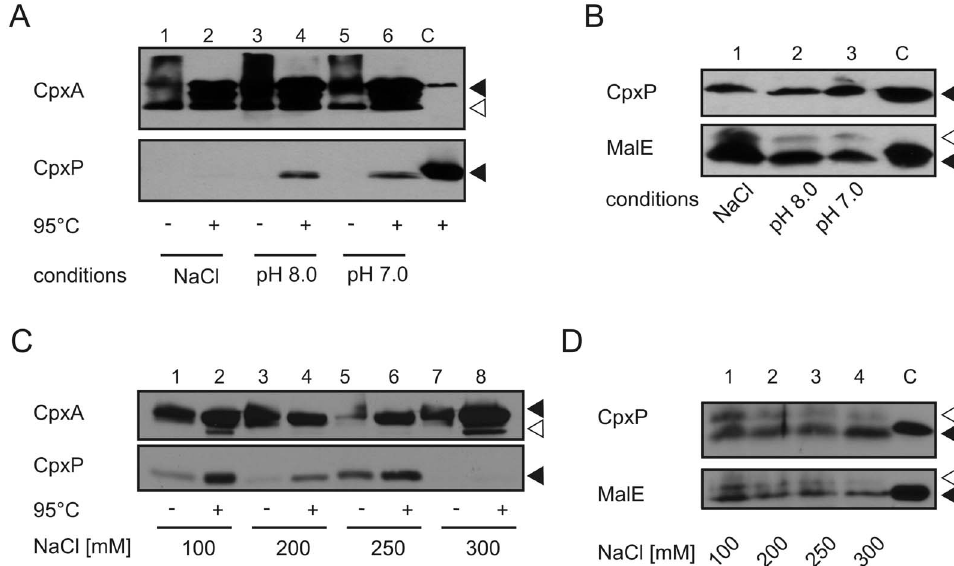
Figure 4. Salt but not alkaline pH disturbs the direct interaction between CpxP and CpxA. A) mSPINE experiments were performed as described in Fig. 2A with E. coli TG1 producing CpxA-Strep (pKT01E) and CpxP (pBcpxP) grown in standard LB (pH 7.0), in buffered medium with alkaline pH (pH 8.0) and in LB adjusted to 0.3 M NaCl (NaCl). Purified CpxA-His6 and His6-CpxP served as controls for antibody specificity (C). Black triangles show specific and the white triangle unspecific reactions. Shown are representatives of three biological replicates. B) To verify similar CpxP protein level in each mSPINE experiment, whole cells from (A) were collected after formaldehyde treatment, and subjected to immunological determination using antiserum to the CpxP protein, and the MalE protein (loading control), respectively. Purified His6-CpxP and MalE served as controls for antibody specificity (C). Black triangles show specific and the white triangle unspecific reactions. C) mSPINE experiments were performed as described in (A) with E. coli TG1 producing CpxA-Strep (pKT01E) and CpxP (pcpxP) grown in standard LB (pH 7.0), and in LB supplemented to indicated NaCl concentrations. Purified CpxA-His6 and His6-CpxP served as controls for antibody specificity (C). Black triangles show specific and the white triangle unspecific reactions. Shown are representatives of two biological replicates. D) To verify similar CpxP protein level in each mSPINE experiment, whole cells from (C) were subjected to immunological determination using antiserum to the CpxP protein, and the MalE protein (loading control), respectively. Purified His6-CpxP and MalE served as controls for antibody specificity (C). Black triangles show specific and white triangles